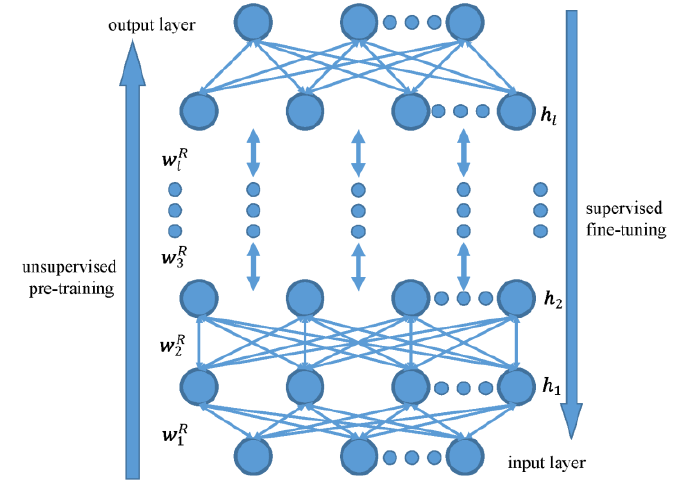
Figure 2. Deep belief network structure [100].